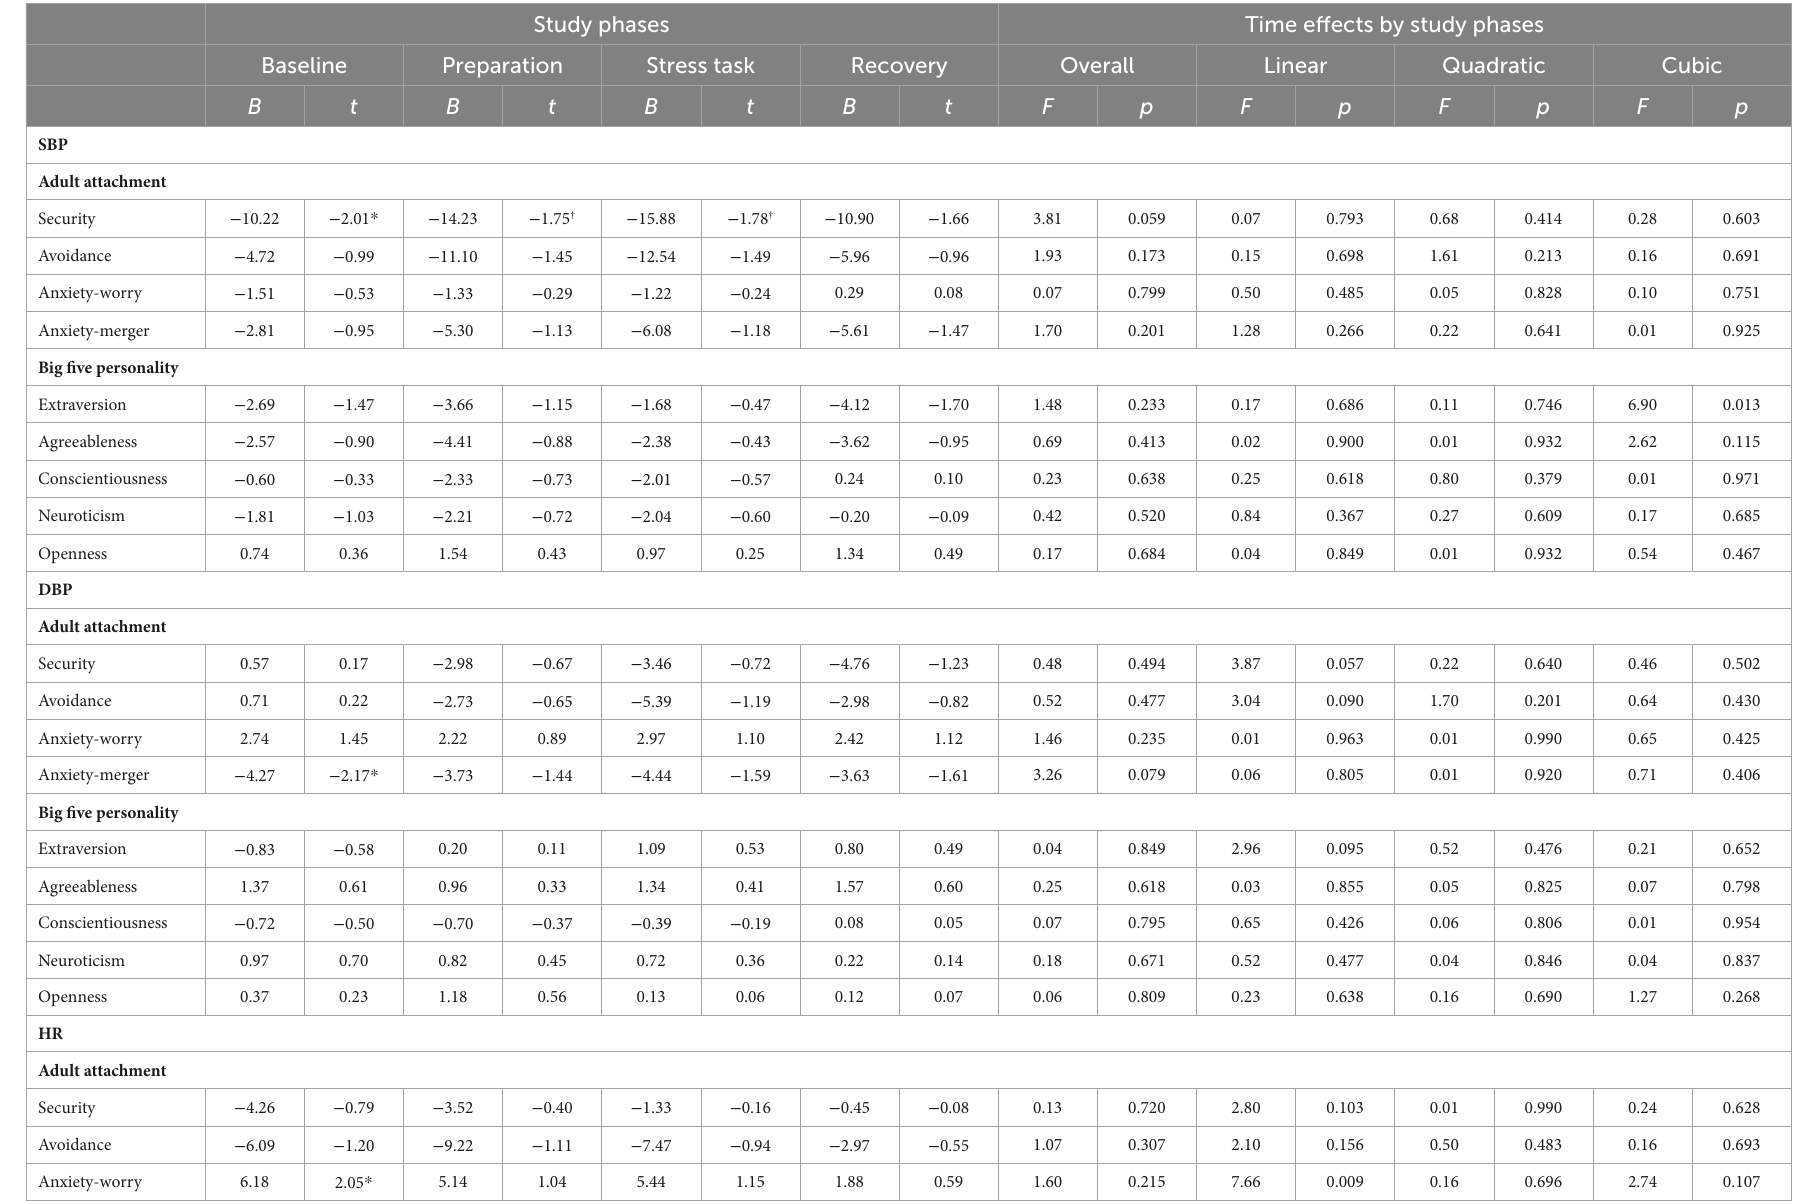
TABLE 3 Individual difference effects on cardiovascular activity indicators and negative